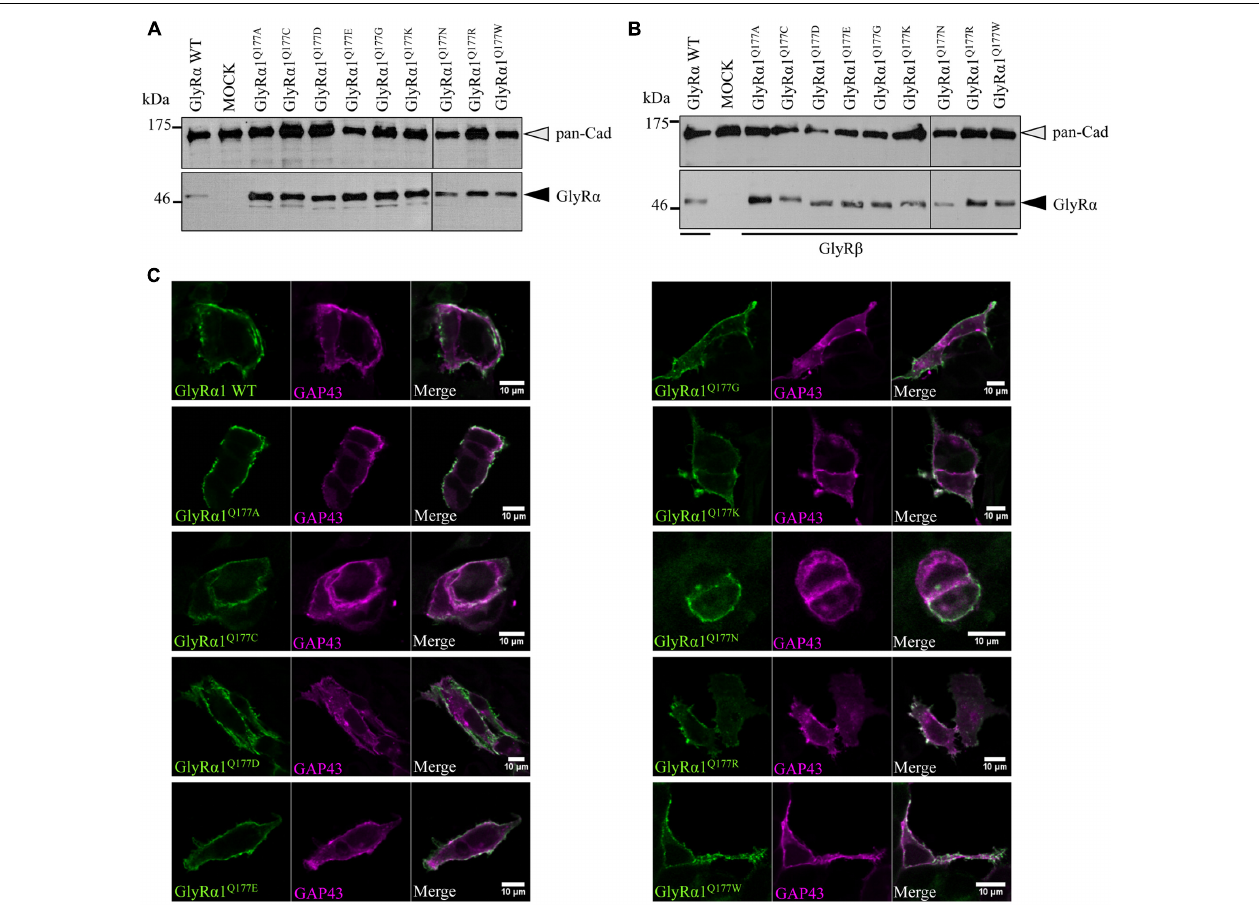
FIGURE 2 | GlyR α 1 Q177 variants are expressed. (A,B) Crude whole cell lysates of HEK293 cells transiently expressing GlyR α 1 WT or GlyR α 1 Q177 variants without GlyR β (A) or with GlyR β (B) co-expression (black arrowhead, mAb4a antibody, 48 kDa). Cells transfected with only GFP served as negative control (MOCK) and pan-Cadherin (gray arrowhead, pan-Cadherin antibody, 135 kDa) was used as loading control. (C) HEK293 cells were co-transfected with GlyR α 1 WT or GlyR α 1 Q177 variants and a plasma membrane marker (GAP43 fused to dsRed, false color magenta). GlyR α 1 WT and GlyR α 1 Q177 variants were detected with the GlyR α 1-specific mAb2b antibody (green) using cell staining to label surface receptors only. The overlay between GAP-43 and GlyR α 1 WT or GlyR α 1 Q177 variants is shown in white (right column). The white bar refers to 10 µ M.